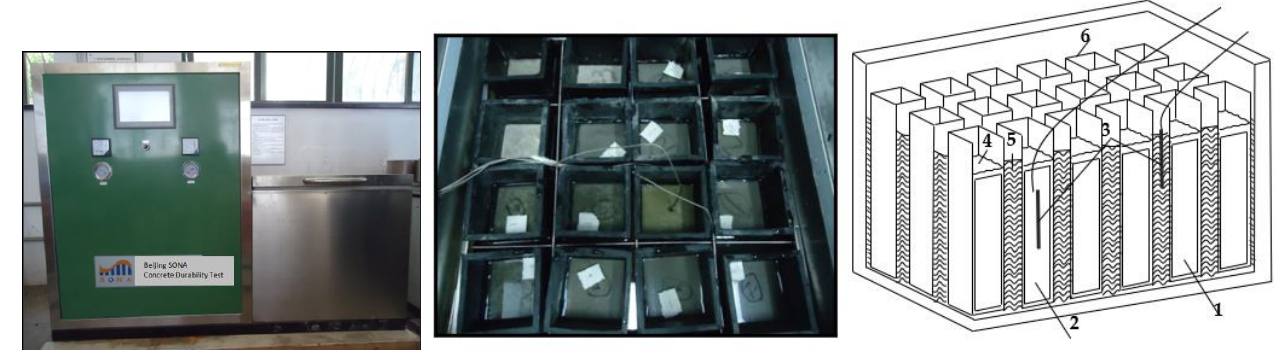
Figure 2. Schematic diagram of rapid freeze – thaw testing equipment(1 — Specimen; 2 — Specimen for temperature measurement; 3 — Thermocouples; 4 — Water; 5 — Liquid antifreeze agent; 6 — Rubber box).